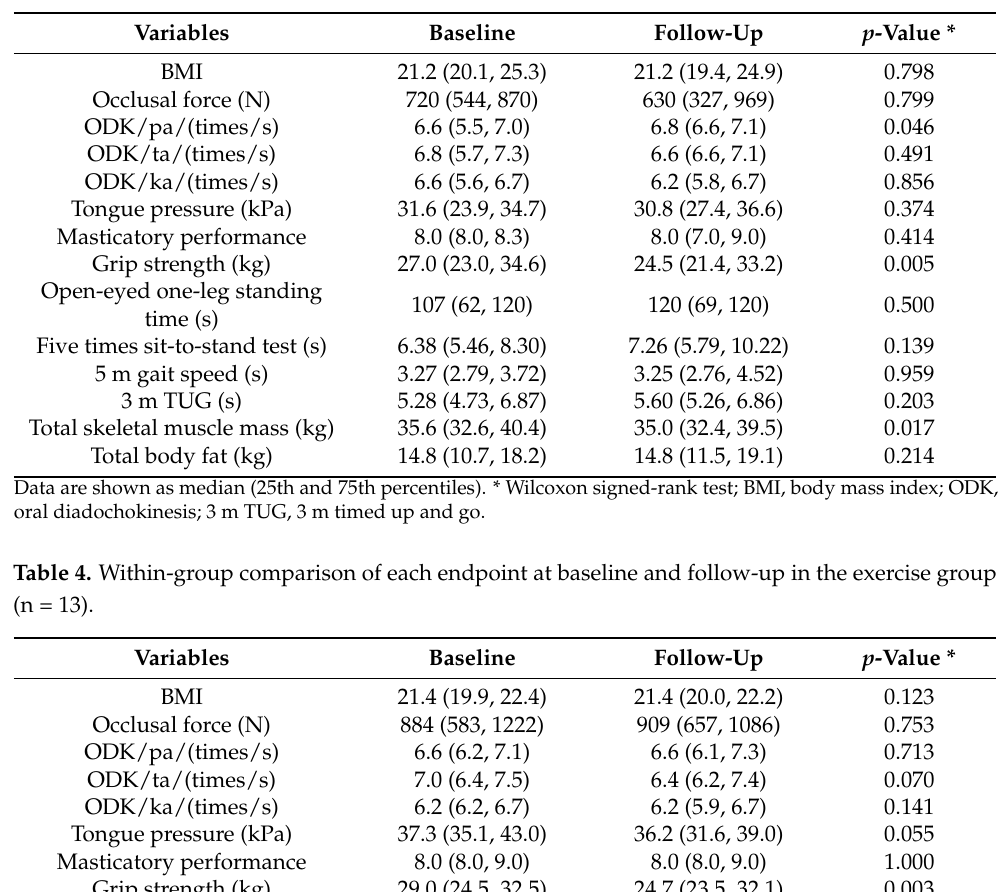
Table 3. Within-group comparison of each endpoint at baseline and follow-up in the keyboard harmonica group (n = 10).